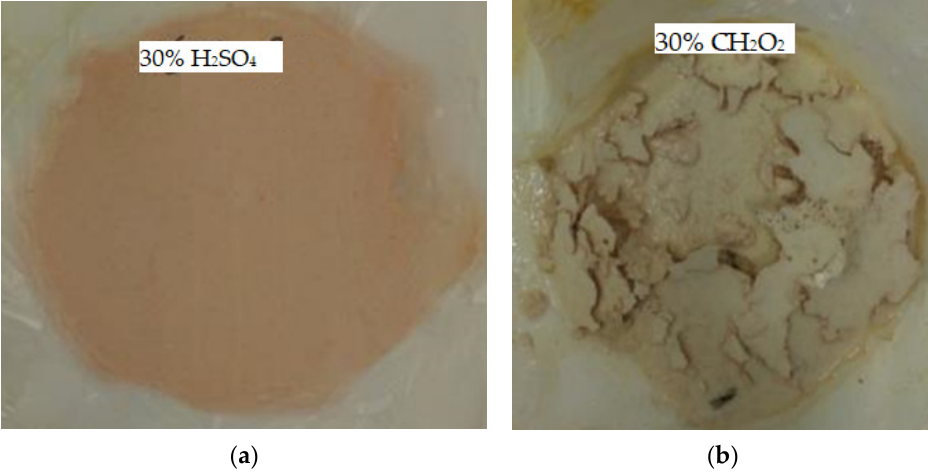
Figure 8. Coating NBR-GF after chemical stress: ( a ) colour change of the coating exposed to 30% H 2 SO 4 for 120 days; ( b ) cracking of the coating exposed to 30% CH 2 O 2 for 90 days.